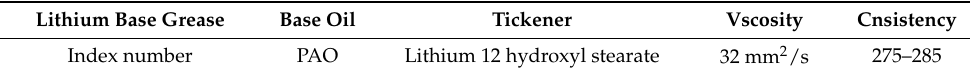
Table 1. Properties of base grease.